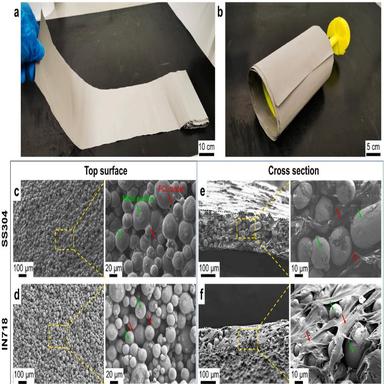
Overall view of flexible powder sheet (a); Powder sheet rolled on a roller (b); SEM observations of the top surface of SS304 (c) and IN718 (d) and the crosssection for SS304 (e) and IN718 (f) powder sheets.